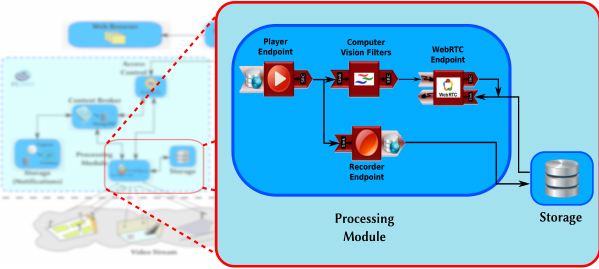
Figure 3. Kurento’s Media Pipeline